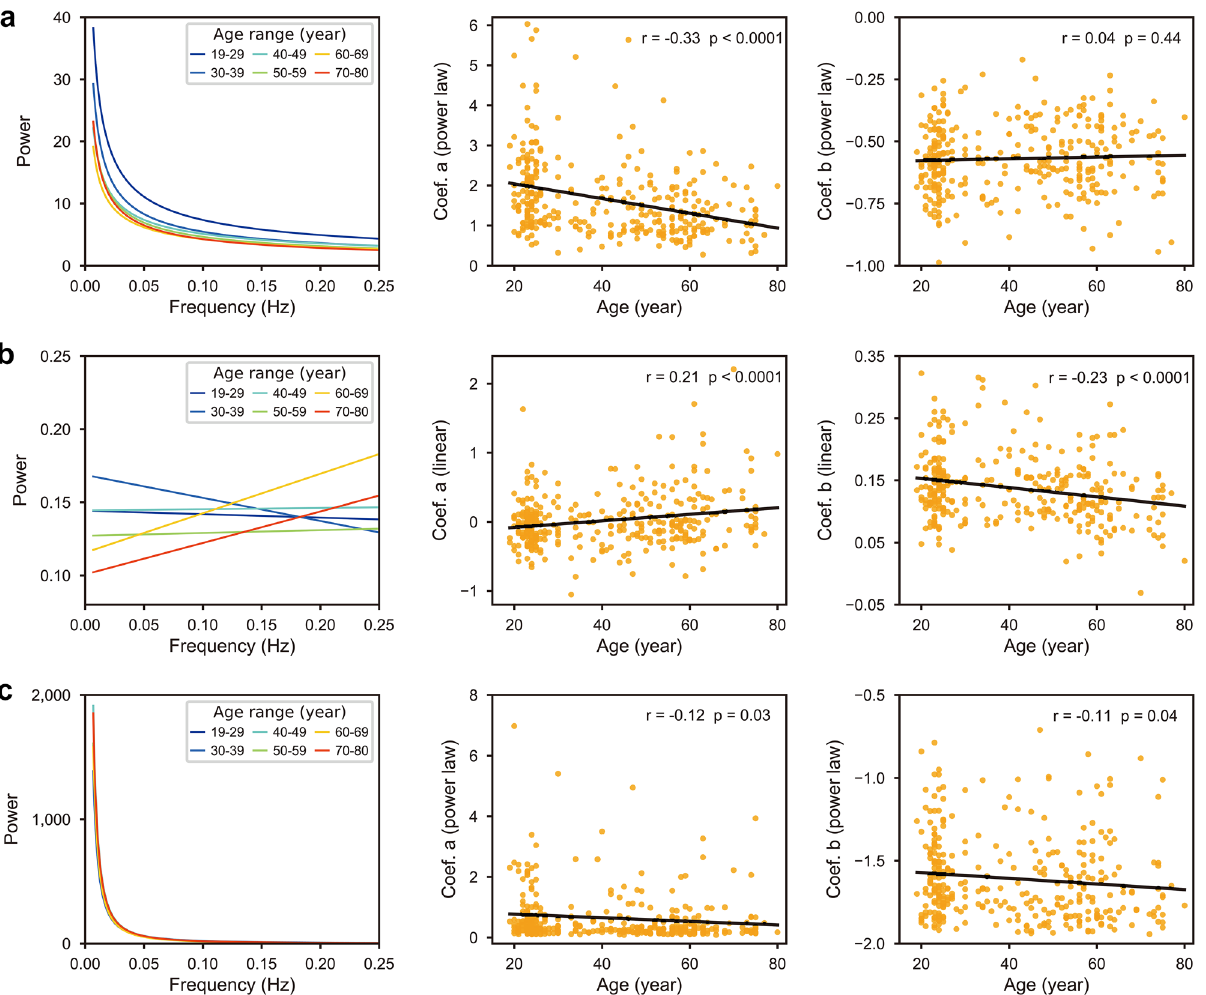
Figure 2. The relationship between age and the trend of power spectrum of GS. ( a ) Original data. ( b ) De-convolved data. ( c ) Data without noise regression. Column 1: the trend of GS. Each line represents the average trend of subjects every 10 years. Column 2 and 3: the correlation between age and coefficient a and b of trend functions,